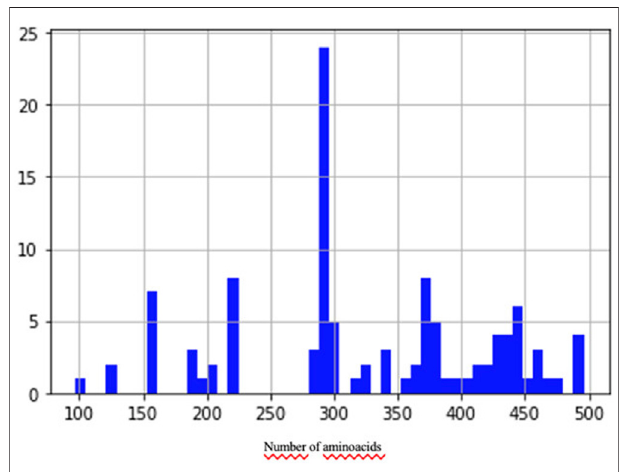
FIGURE 3 | Distribution of protein sequence length in the data set.